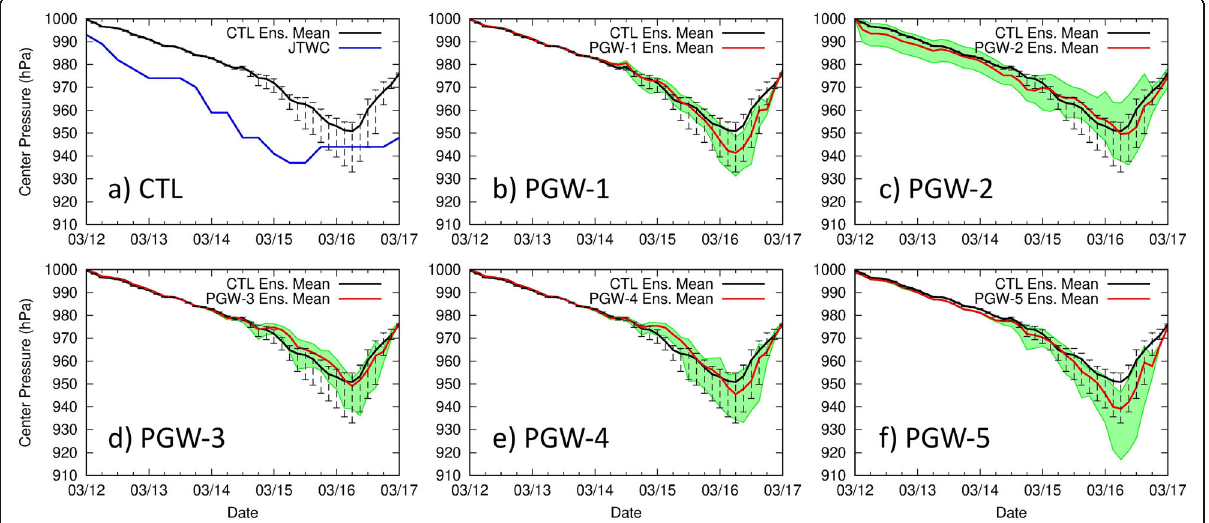
Fig. 10 Temporal variations in the center pressure of TC Tomas in the CTL and PGW simulations. a The black line is ensemble mean center pressure of the CTL. Dashed vertical bars indicate the ensemble spread of the CTL. The blue line is center pressure of JTWC. b – f The results of each PGW simulation. The red line and the green shading indicate the ensemble mean center pressure and the range of the ensemble spread, respectively. The result of the CTL is also shown in each